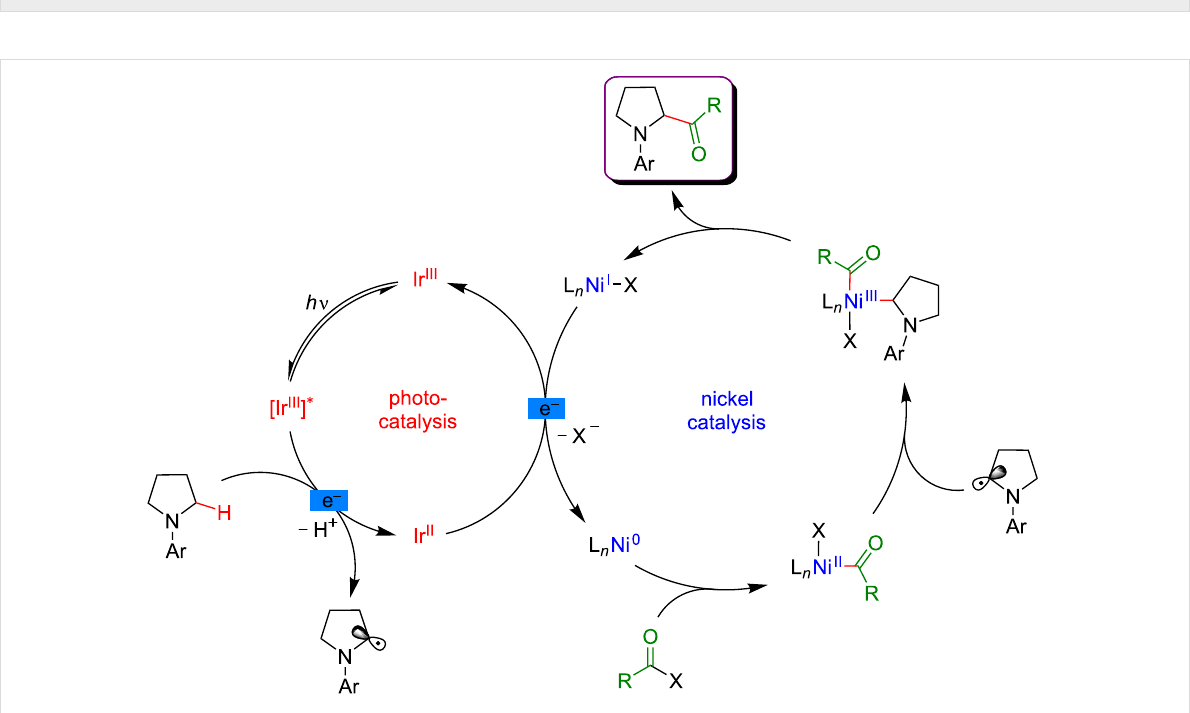
Figure 67: Proposed mechanism for the C–H acylation of amines via dual Ni/photoredox